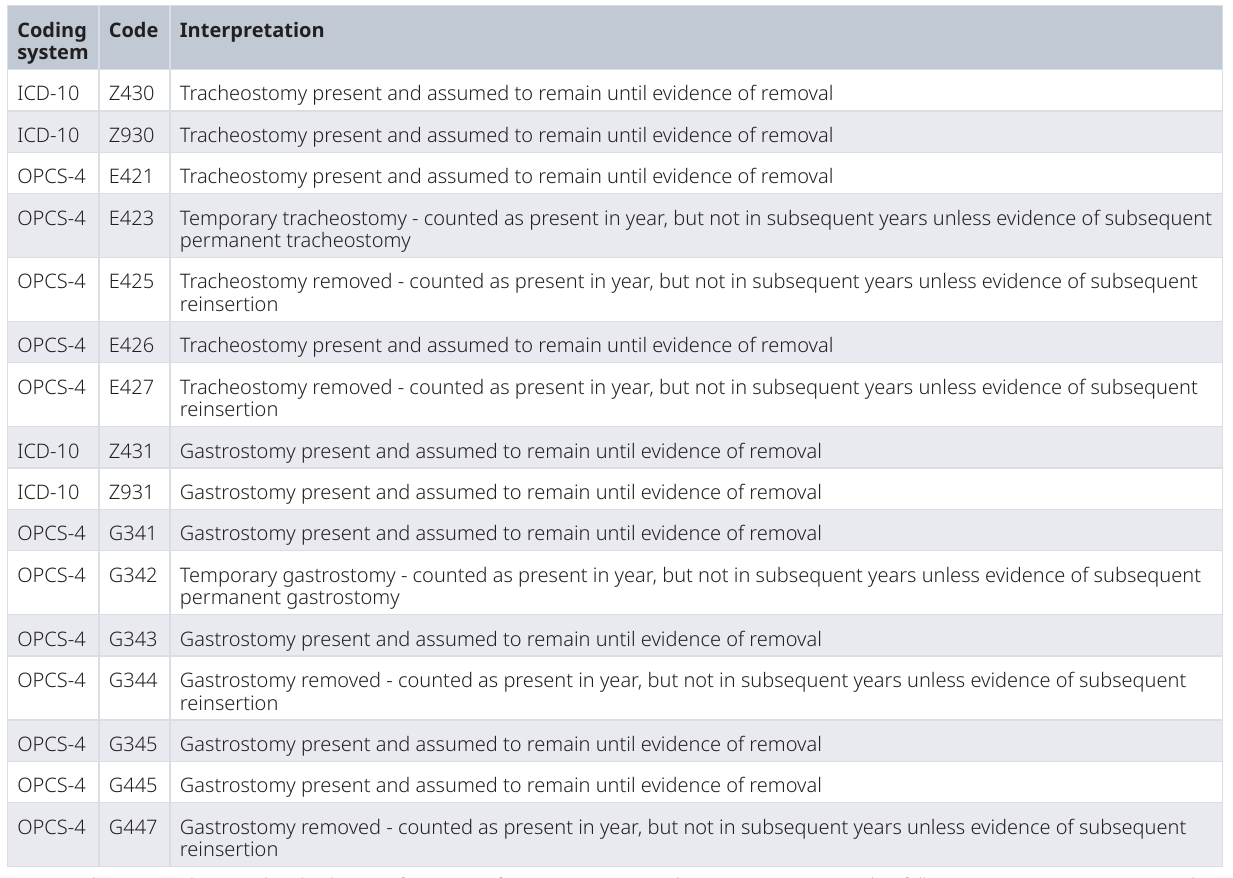
Table 4. Codes used to identify presence of gastrostomies and tracheostomies.